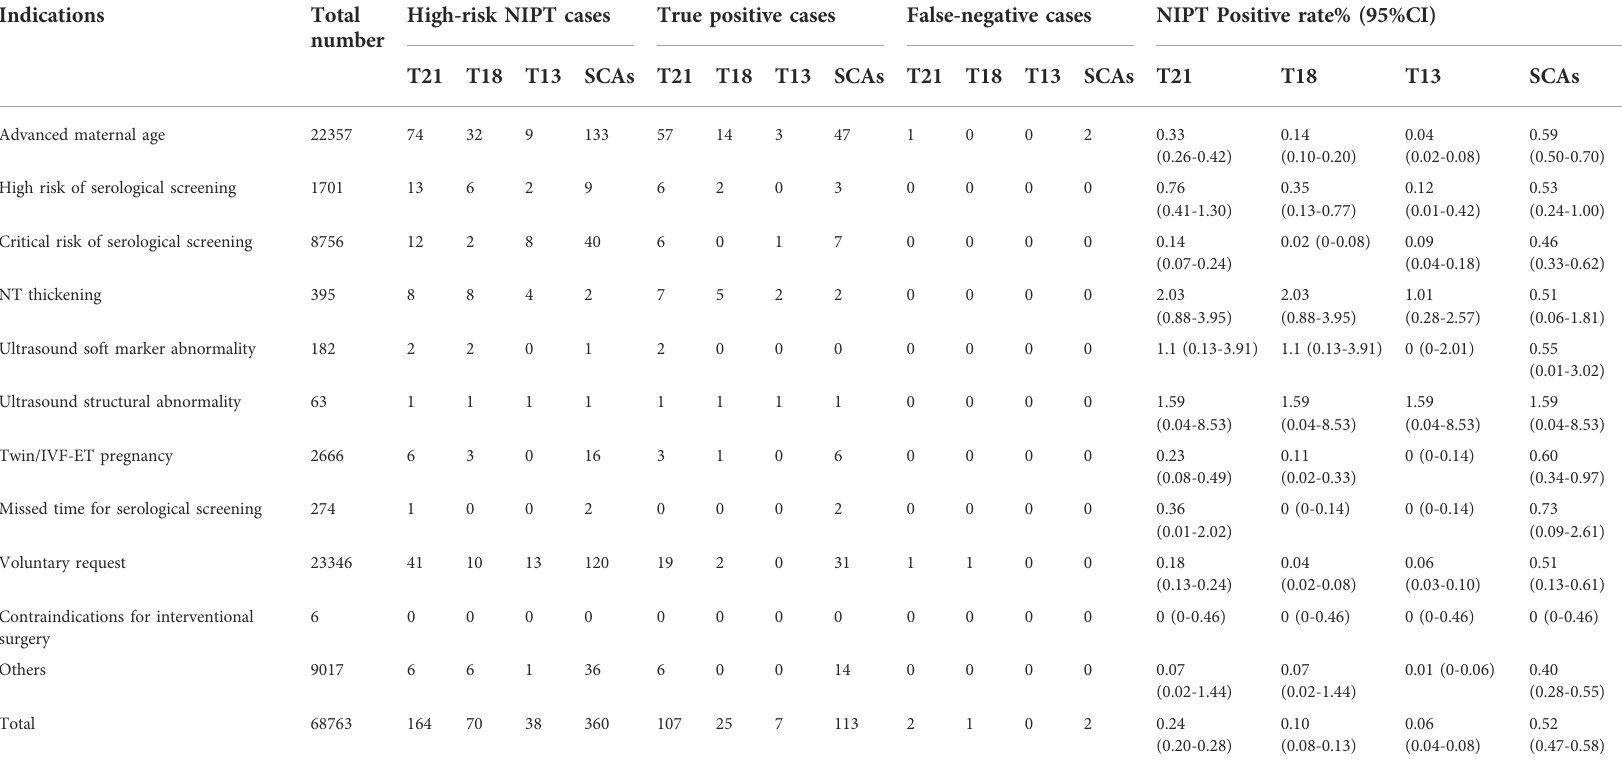
TABLE 4 Aneuploidy positive rates according to NIPT screening